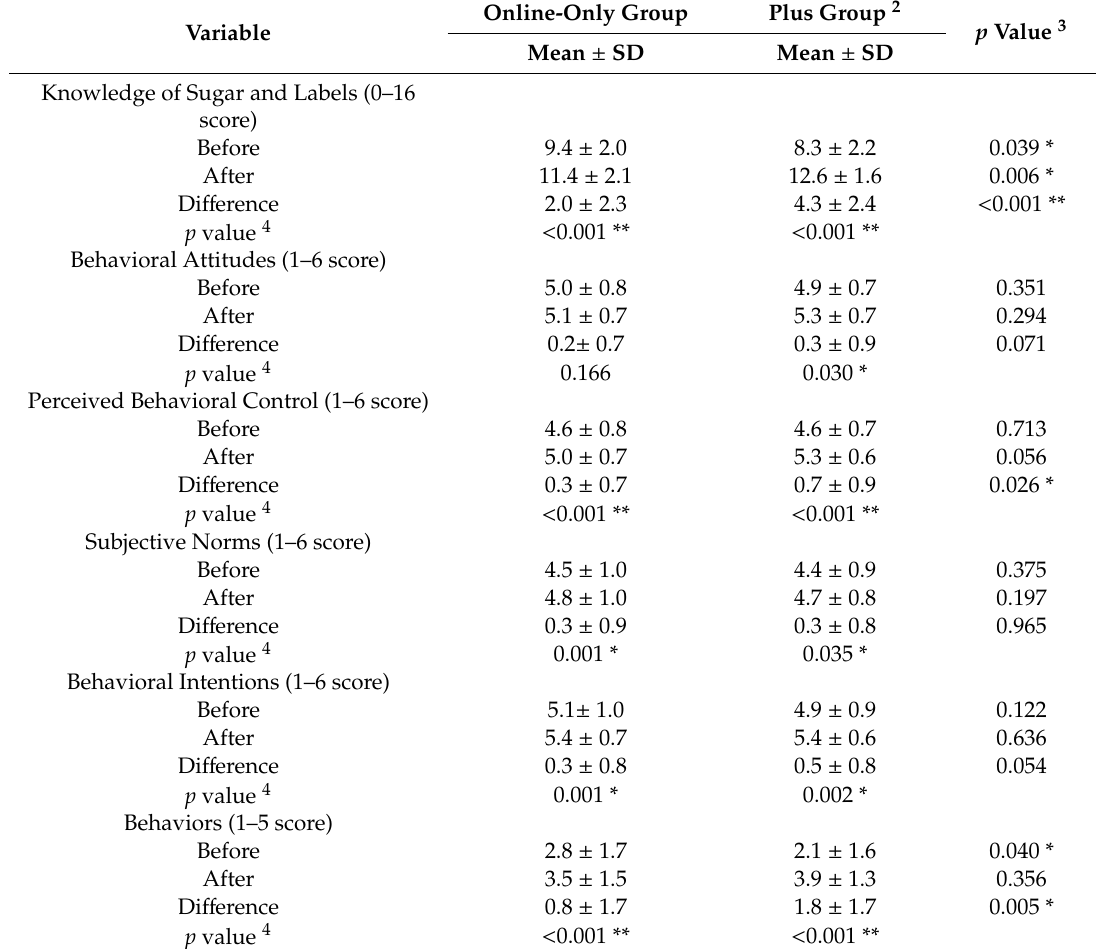
Table 2. Changes in knowledge and theory of planned behavior (TPB) before and after the intervention in both groups.